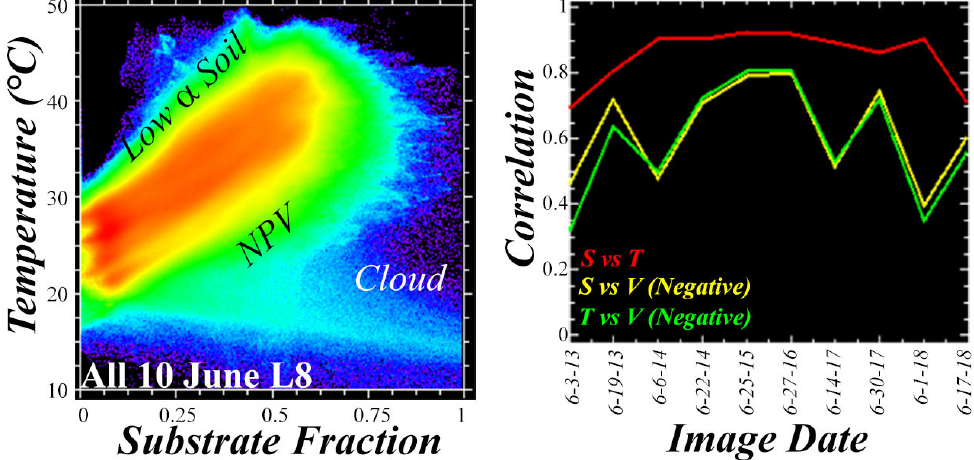
Figure 6. Composite relationship between S and T. Left: A consistent linear relationship between S and T is observed for nearly every June scene in the Landsat 8 archive, but the composite space of all 10 acquisitions is less obviously linear because significant image-to-image variability exists in air temperature. Right: Correlation between coincident S, V and T images for each date. The observed (+) correlation between S and T is stronger in every case than the well-known (-) correlation between V and T. Because the S vs T correlation is so strong, the S vs V and T vs V correlations are very similar.